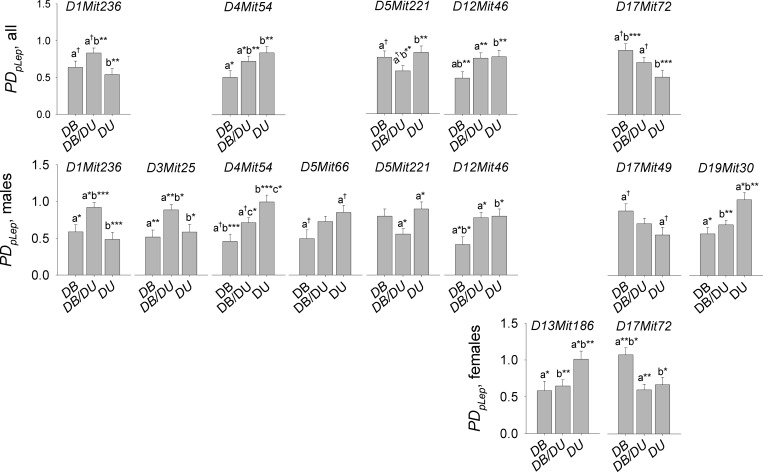
Mean phenotypic dispersion in plasma leptin (PDpLep) from Tobit limited model analysis in a cohort of 233 F2 DBA/2× DU6i house mice (Mus musculus) (Brockmann et al.) by marker.The significance of differences among mean PDpLep by genotype (P < 0.05*, < 0.01**, < 0.001***) was determined using general linear contrast statements.